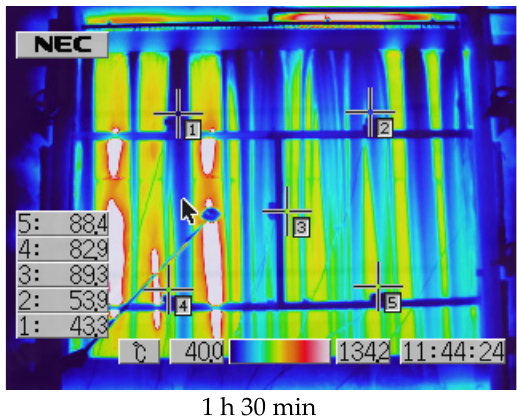
Figure 11. The temperature distribution on the curtain surface measured with an infrared thermal imager.